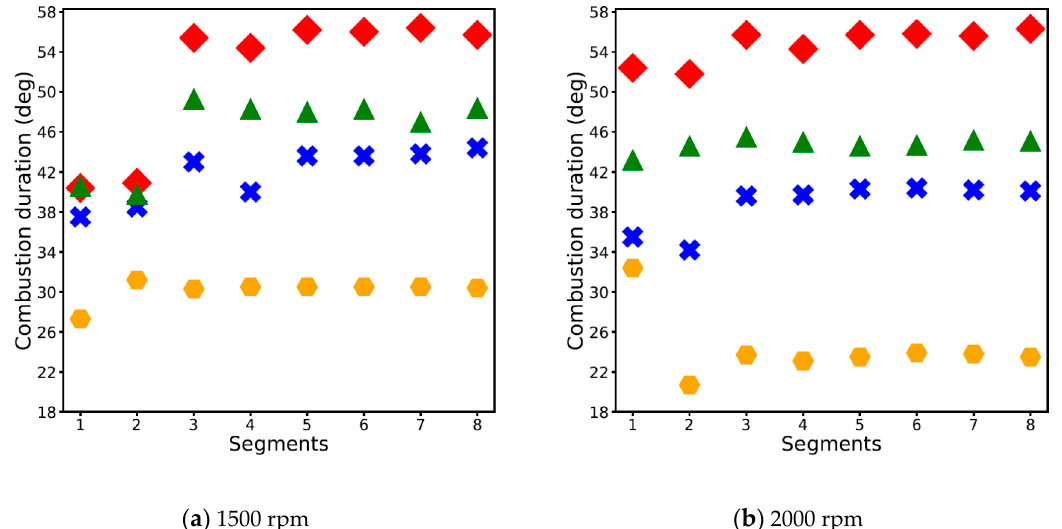
Figure 13. Combustion duration at all loads in each stage at ( a ) 1500 rpm and ( b ) 2000 rpm. The red thick diamond represents 100% load, the blue thick cross 50% load, the green triangle 75% load and the orange hexagon 25% load.